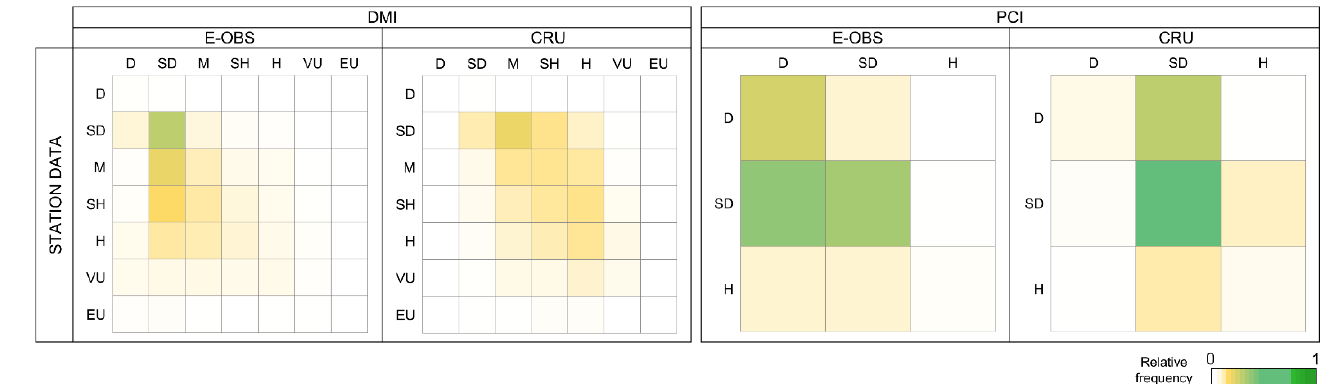
Figure 5. Normalized contingency matrices for aridity classification using the three considered databases: De Martonne (DMI, left ) and Pinna combinative index (PCI, right ).